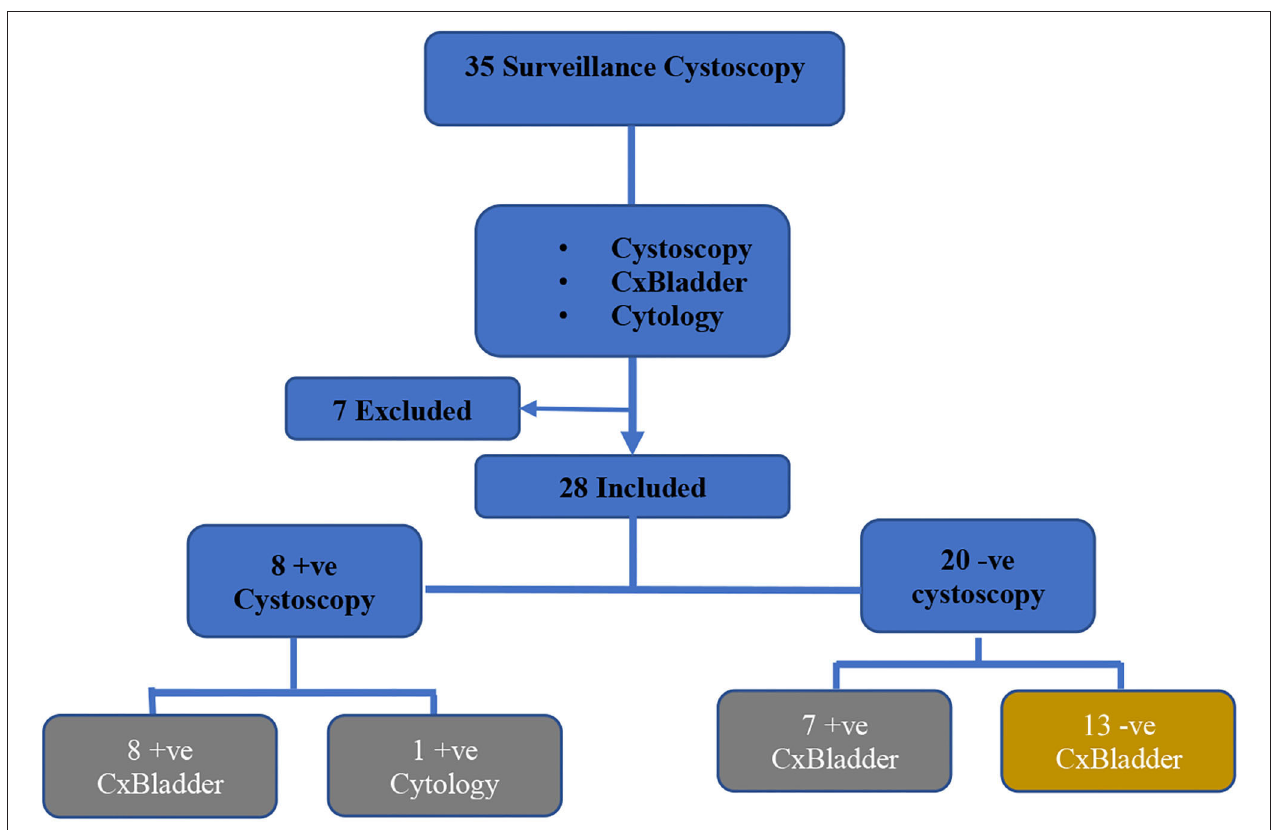
FIGURE 1 | Consort diagram of the selection criteria of bladder cancer cases.